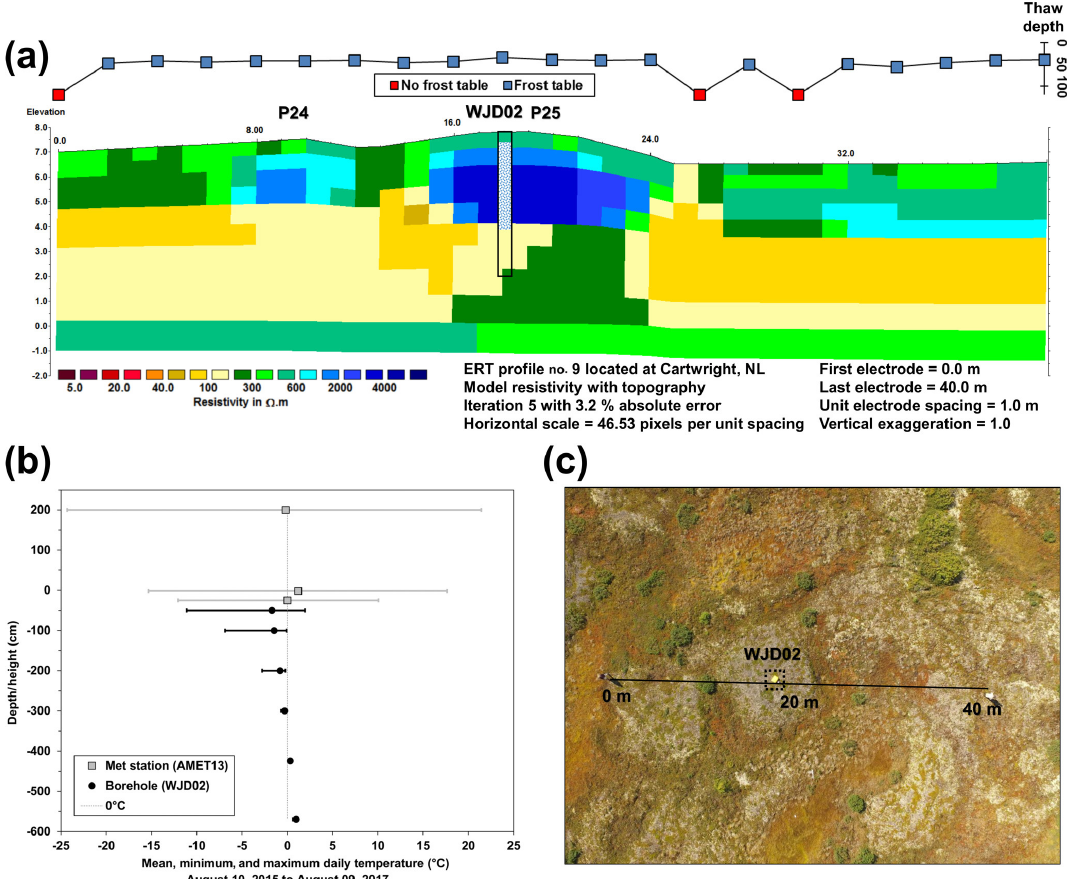
Figure 7. Peatland permafrost at Cartwright. (a) Frost tables and modelled resistivities on ERT profile 9. Depths with permafrost in borehole WJD02 are denoted by hatching. (b) Air temperature (from nearby station AMET13) and ground temperature envelopes (2015–2017). (c) UAV vertical image of the site. Black line delimits the approximate location of the ERT survey line and text shows the start and end